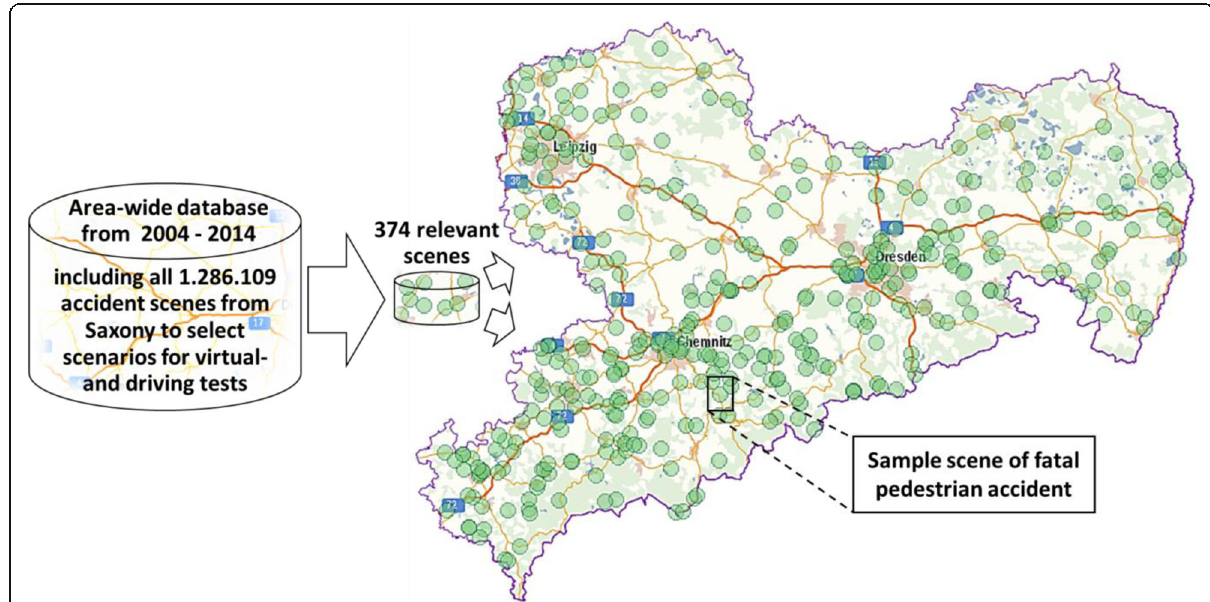
Fig. 8 Area-wide locations of accidents that included limited weather conditions and reduced visibility for machines and humans (Data for positions © state-owned geo measurement and information, Saxony 2015)